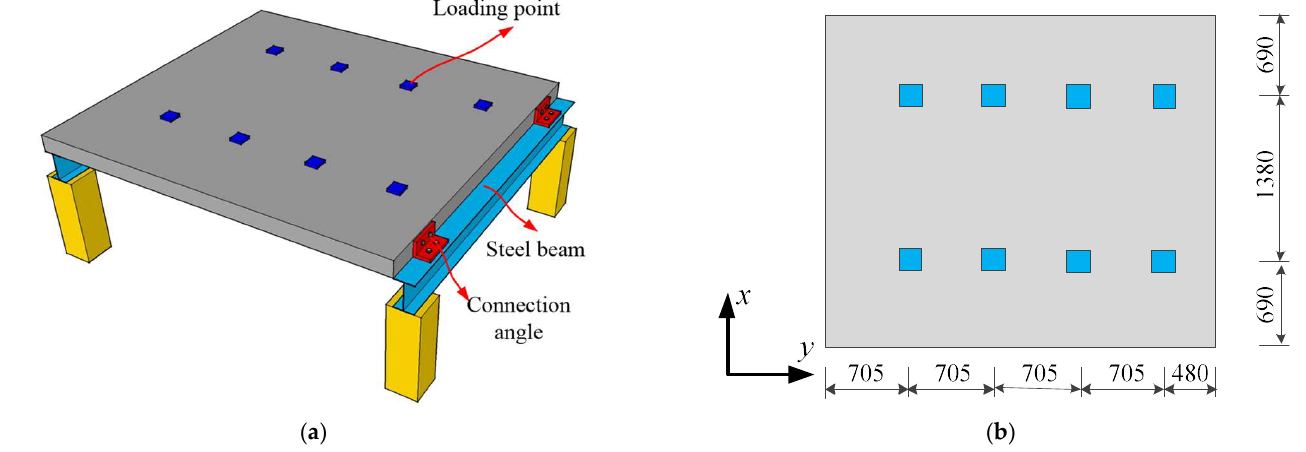
Figure 4. Layout of loading points (Unit: mm). ( a ) Loading schematic. ( b ) Loading points.